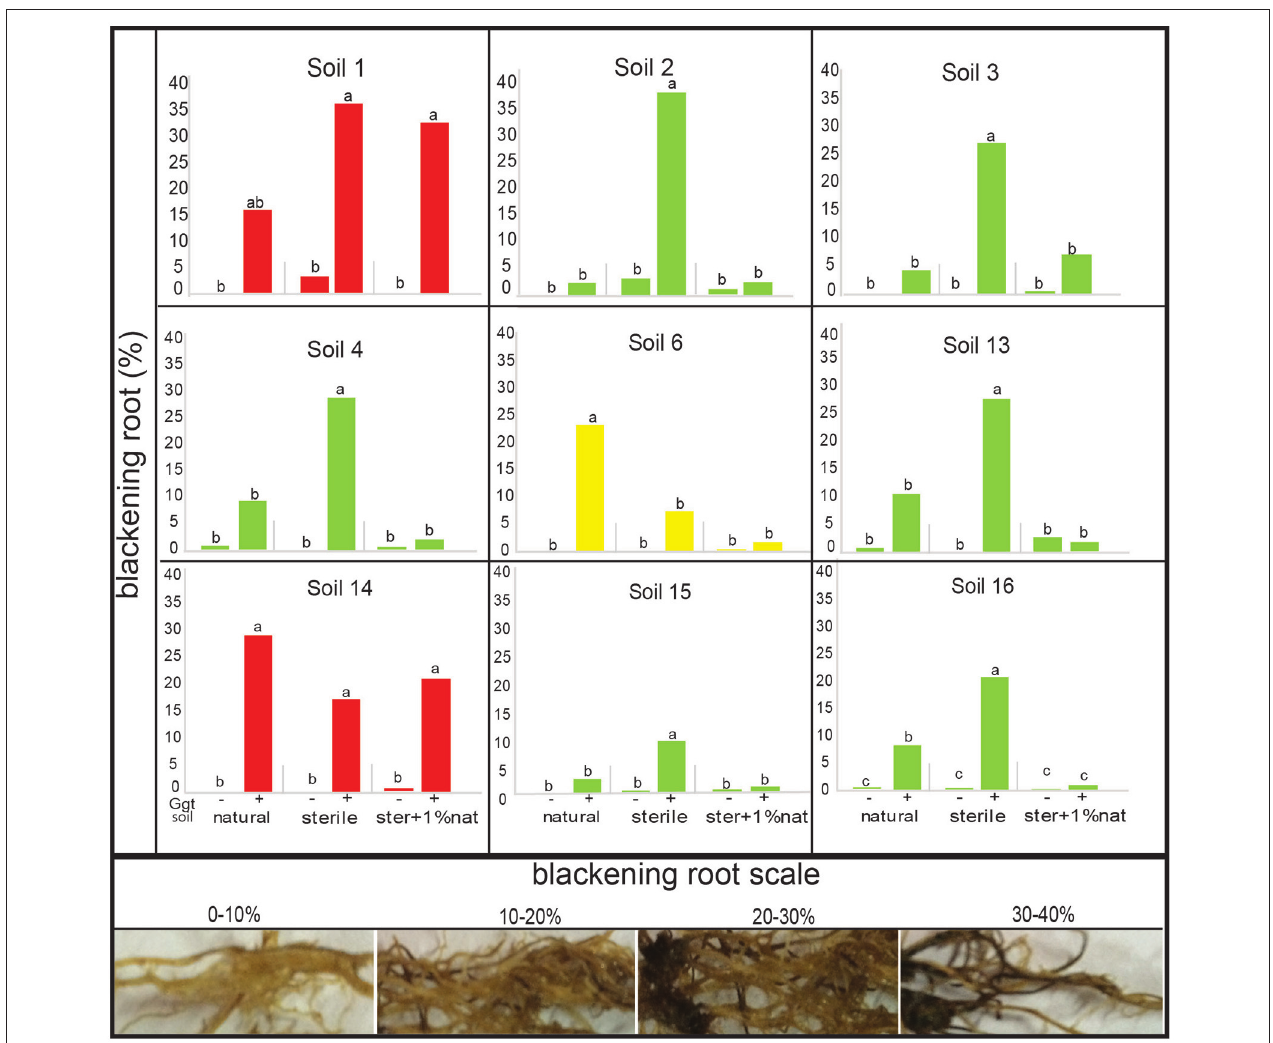
FIGURE 5 | Take all disease symptoms (root blackening) in wheat plants from the suppressive soil bioassay in greenhouse. Treatments were: natural soil (natural), sterile soil (sterile), and sterile soil supplemented with 1% of natural soil (ster + 1% nat), inoculated ( + ) or not ( − ) by Ggt ( n = 5). The disease index scale used is represented by the pictures in the bottom panel. Tukey’s test was used to compare treatments means, values followed by the same letter do not differ at P ≤ 0.05 ( n = 5). Green bars represent suppressive soils, red bars conducive soils, and yellow bars represent undeterminated